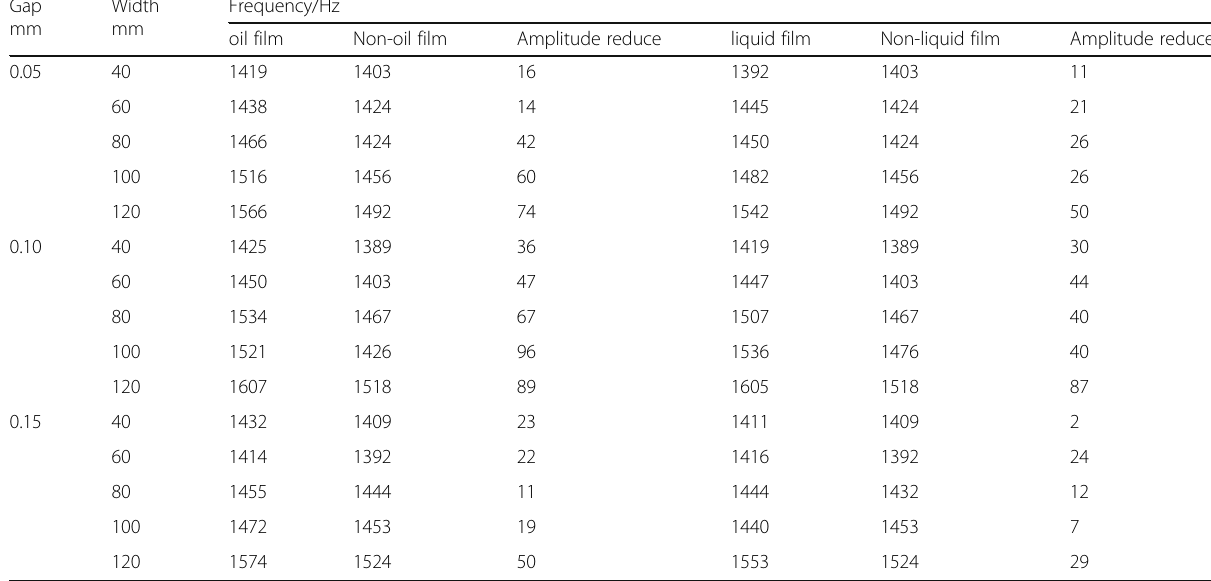
Table 3 Single damping oil film, liquid membrane effect on main frequency Gap Width mm mm